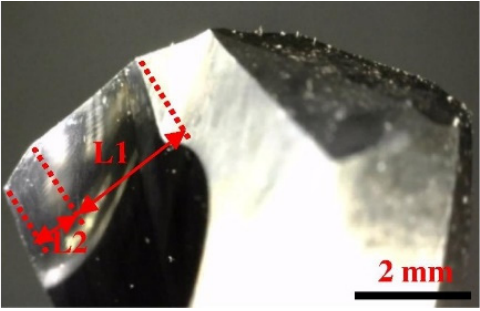
Figure 15. Definition of the principal and secondary lip lengths of the double cone drill [94].